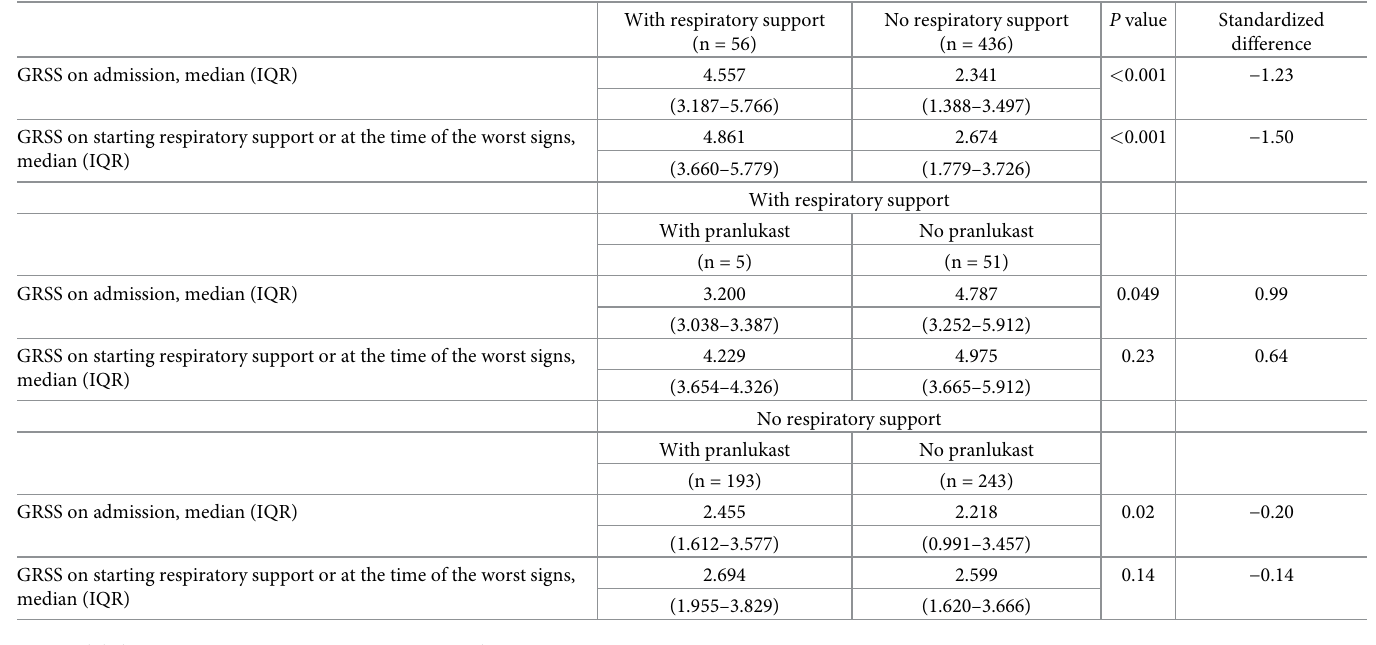
Table 3. Global Respiratory Severity Score on starting respiratory support or at the time of the worst signs before propensity-score matching.